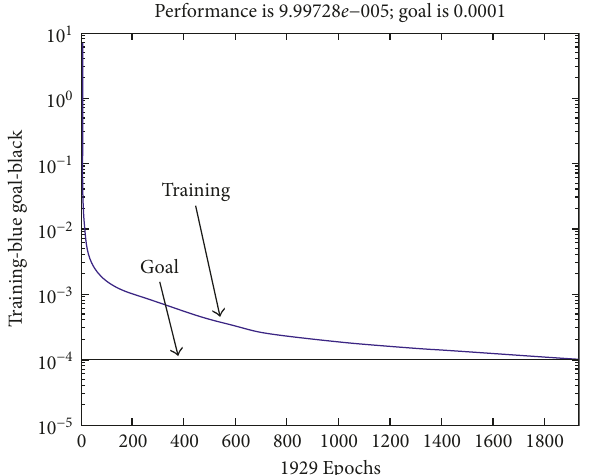
Figure 16: Training performance for the one-step secant back- propagation algorithm of ANN.